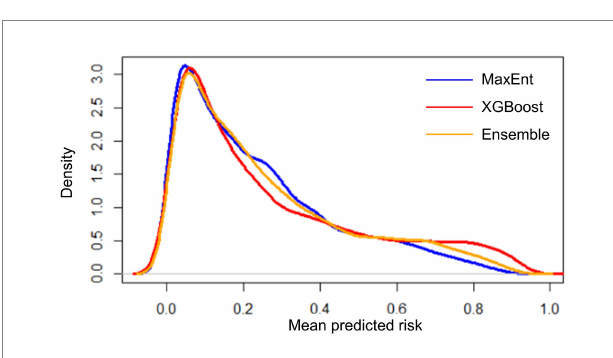
FIGURE 5 Distribution of mean predicted risk of each model output based on kernel density estimation. Spearman’s correlation test was conducted for MaxEnt-XGBoost ( ρ = 0.899, value of p < 0.001), MaxEnt-ensemble ( ρ = 0.969, value of p < 0.001), and XGBoost-ensemble ( ρ = 0.977, value of p <